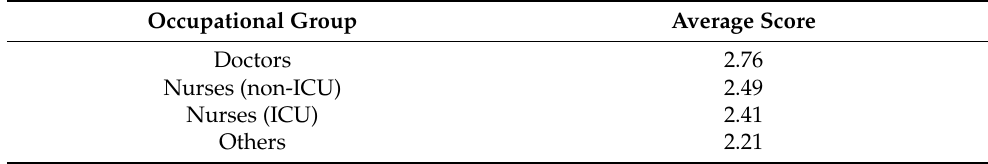
Table 3. Average score on the social inadequacy subscale.